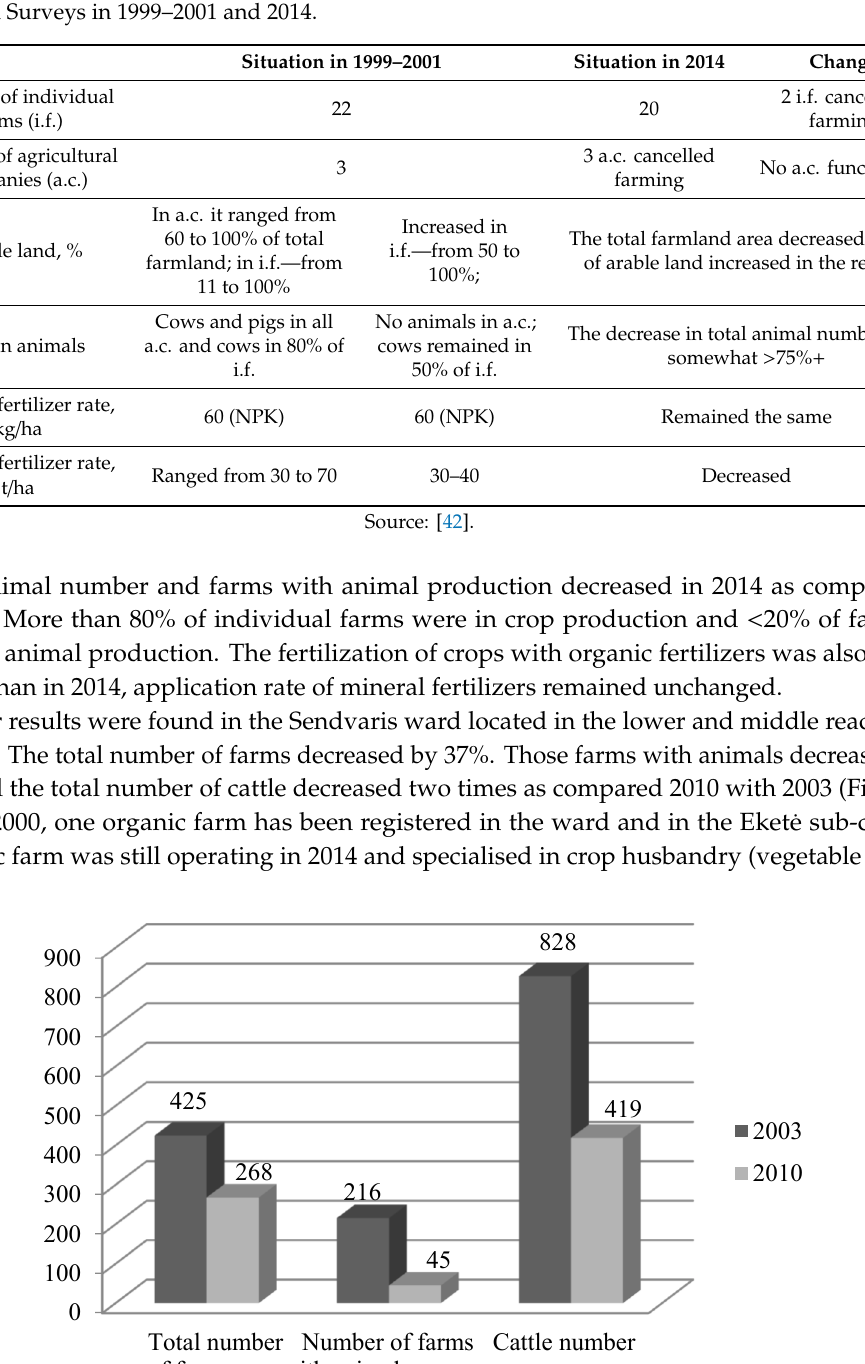
Table 4. Farms and farming intensity in the Eket˙e sub-catchment according to the summarised results